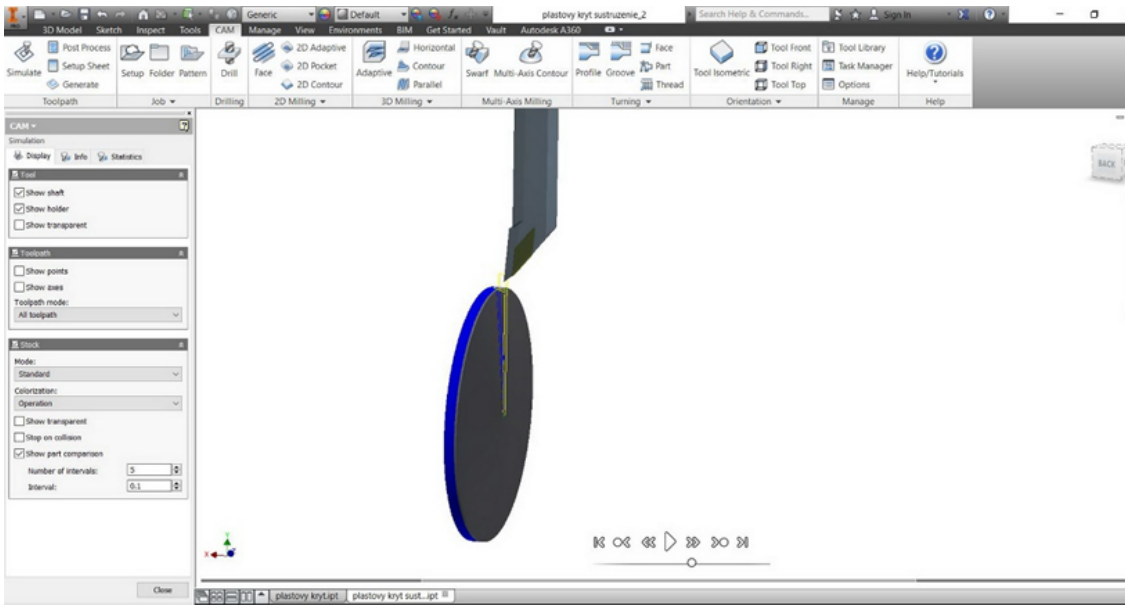
Figure 6: Simulation of the 144 mm diameter machining of the semi-finished piece.